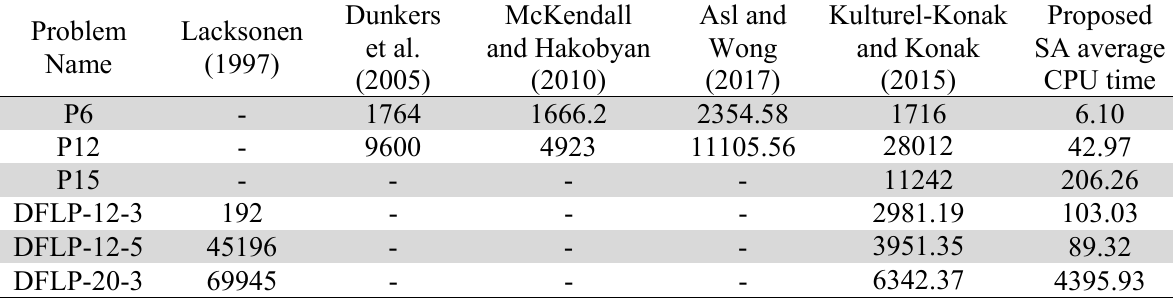
Comparison of proposed FBS based SA heuristic average CPU timings (seconds) with the other approaches CPU timings for UA-DFLPs Problem